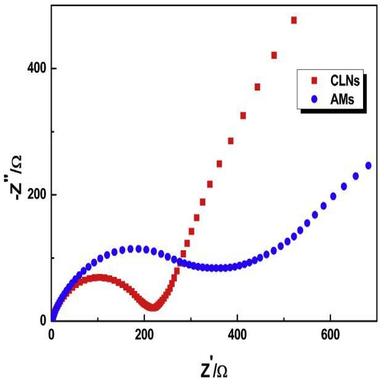
Nyquist plot of CLNs and AMs after 1st cycle at 0.1 C rate.